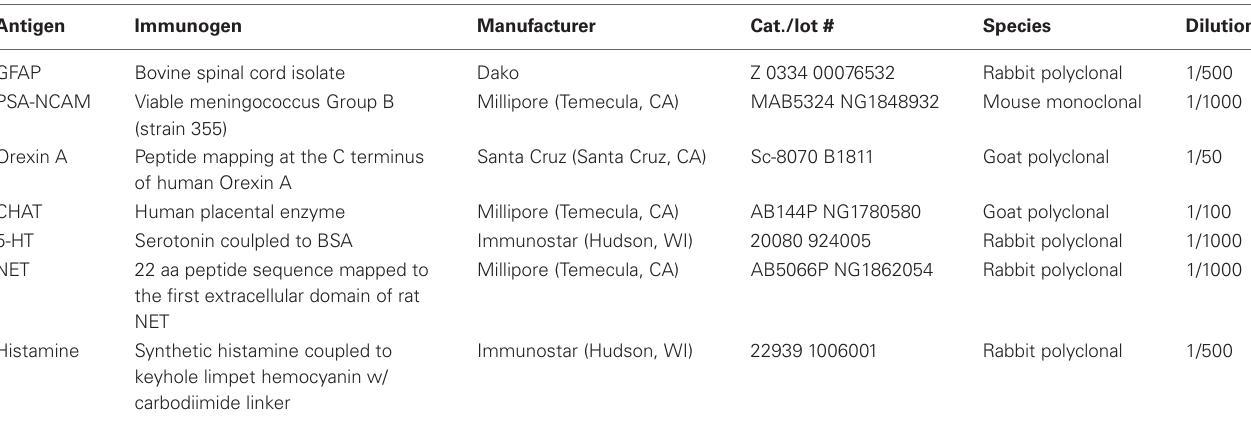
Table 1 | Primary antibodies